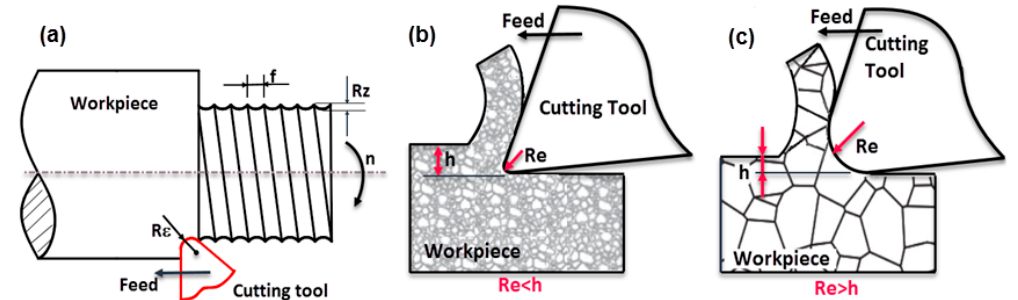
Figure 1. ( a ) Illustration of turning operation showing nose radius (Re), feed rate ( f ), maximum surface roughness (Rz); ( b ) conventional and ( c ) micro-cutting process h: undeformed chip thickness, Re: Edge Radius.